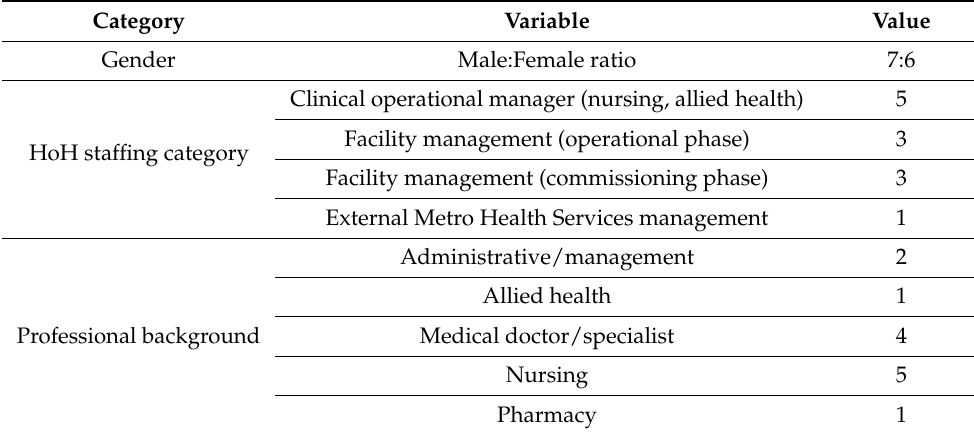
Table 2. Details of key informants used for qualitative